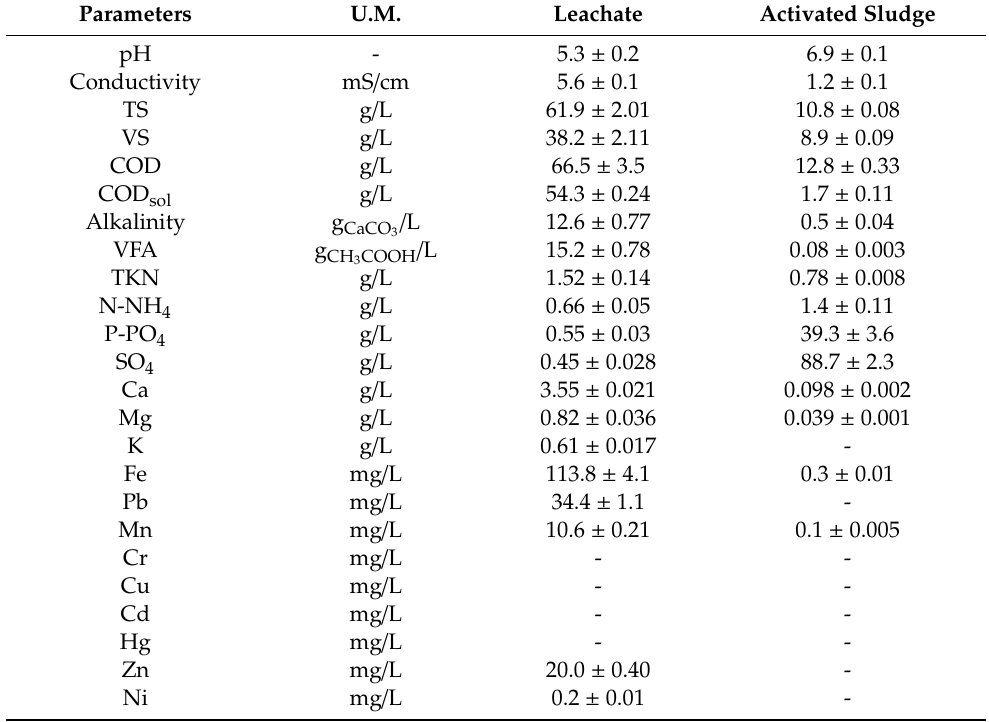
Table 2. Characteristics of compost leachate and activated